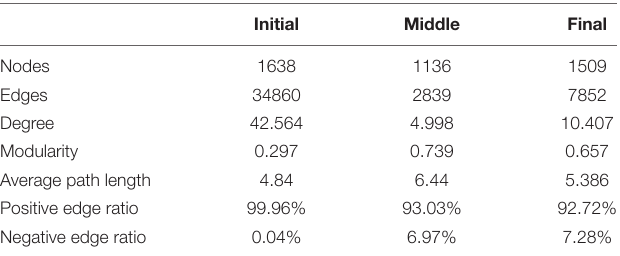
TABLE 1 | Topological parameters of co-occurrence networks based on benthic bacterial communities in the purification area of the IPRS during the culture cycle.